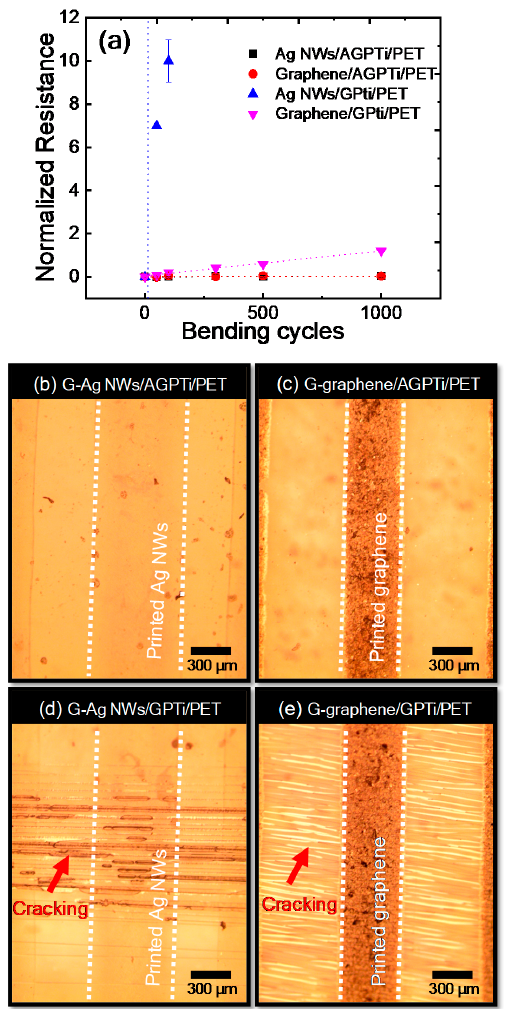
Figure 9. ( a ) Normalized line resistances of the gravure-printed AgNWs and graphene on AGPTi and GPTi as a function of the bending cycle. Optical images of the gravure-printed AgNWs and graphene on AGPTi (( b ) G-AgNWs/AGPTi/PET and ( c ) G-graphene/AGPTi/PET) and GPTi (( d ) G-AgNWs/GPTi/PET and ( e ) G-graphene/GPTi/PET) after 1000 bending cycles.